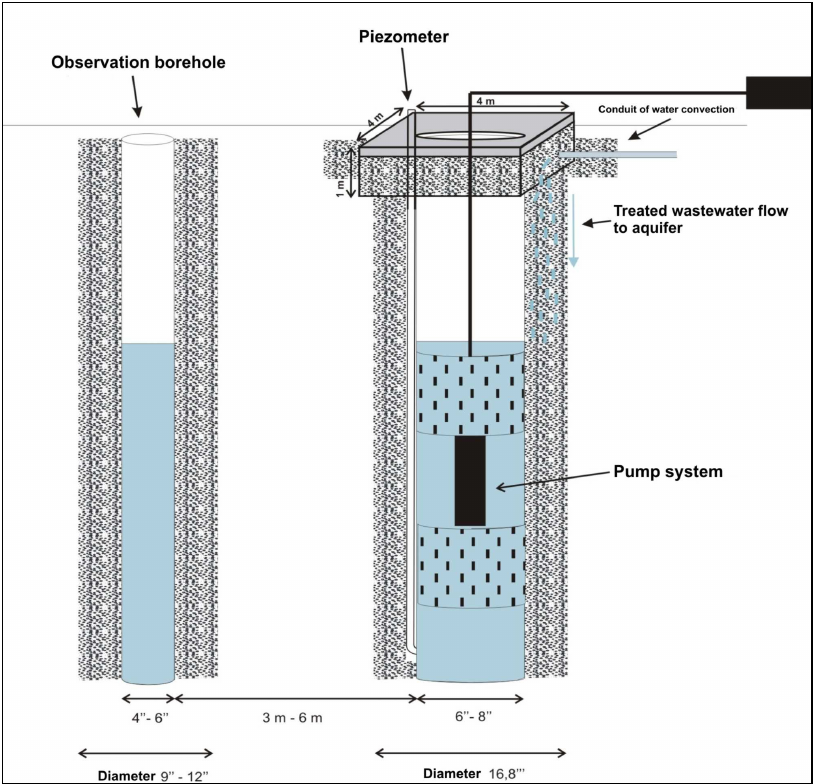
Figure 3. Proposed installation of the recycled water recharge system via deep borehole